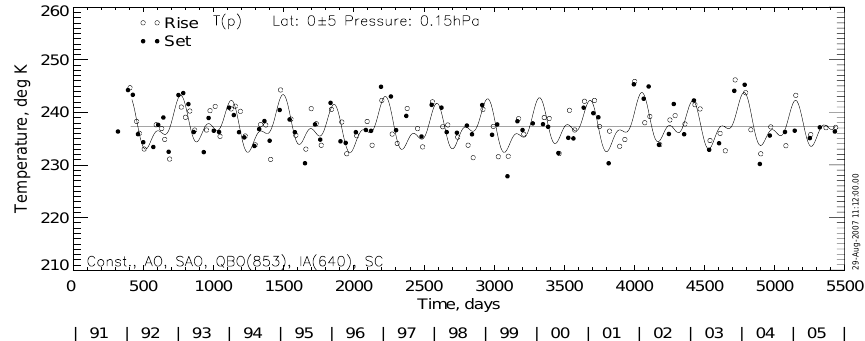
Fig. 2. As in Fig. 1, but the SS and SR points have been adjusted by half the mean SS/SR difference and then refit with the MLR